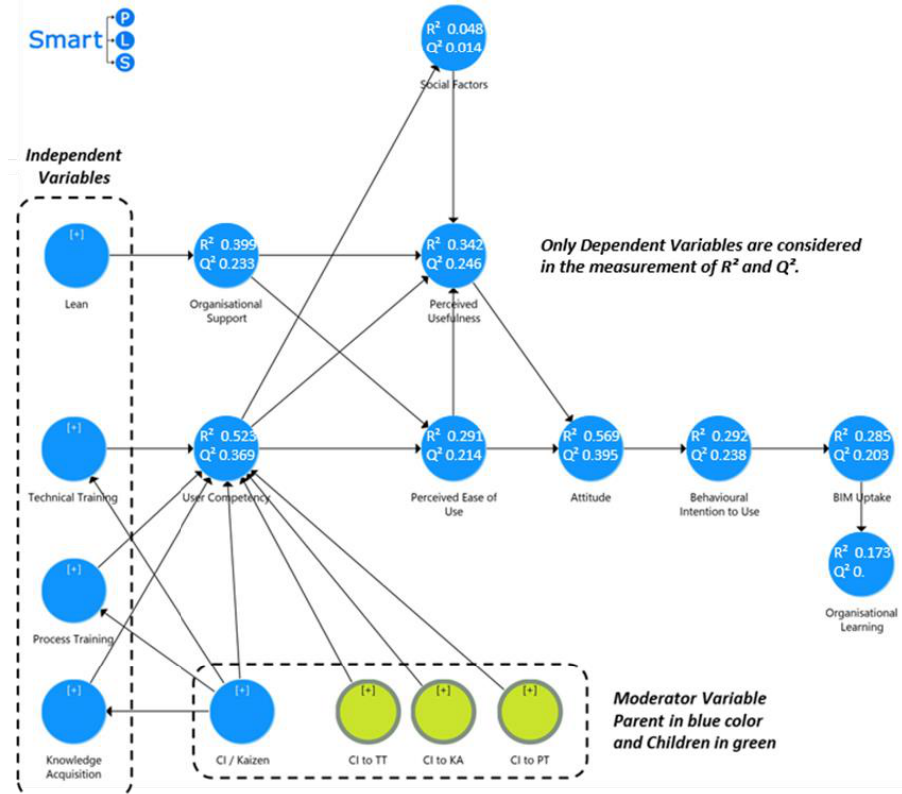
Figure 3. Coefficient of Determination results from SmartPLS 3.0.